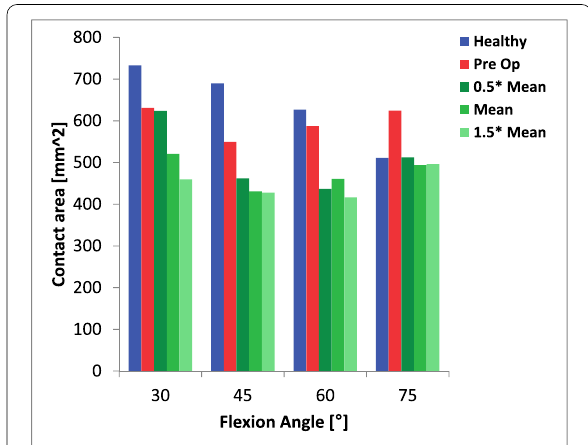
Fig. 6 Patellofemoral contact area as a function of knee flexion angle for the healthy knee model (blue) and for the trochleodysplastic knee both pre- (red) and postoperatively (green) are depicted above. The latter with a varied cut size from 0.5x mean to 1.5x